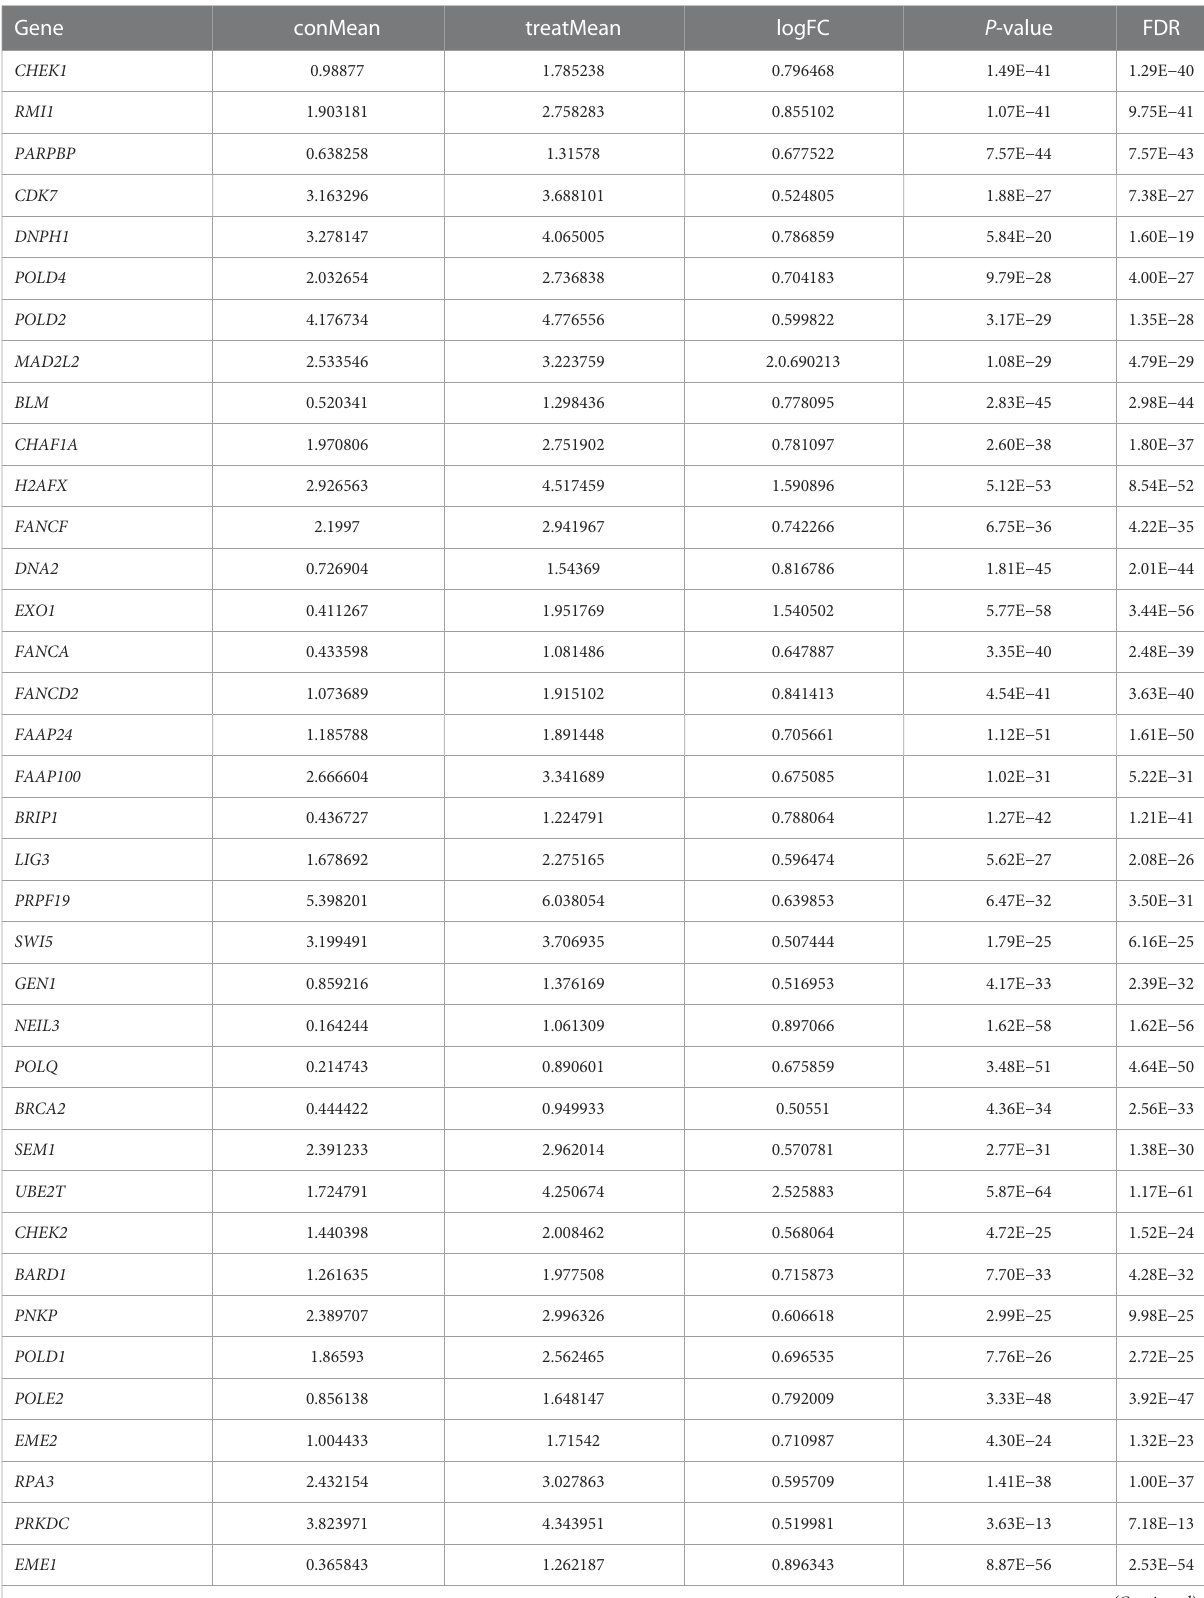
TABLE 1 The expression level of differentially expressed DNA repair genes between normal breast tissues and breast cancer